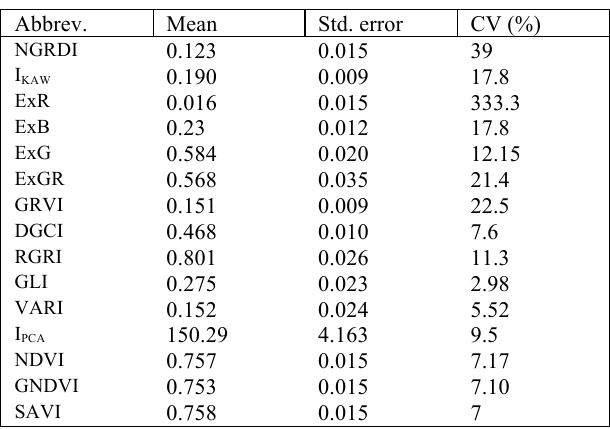
Table3: Descriptive statistic for vegetation indices in 71